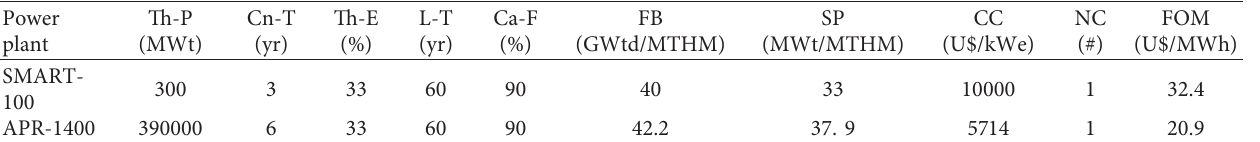
Table 4: The operational parameters of candidate NPPs assumed in this study [33, 48–58].